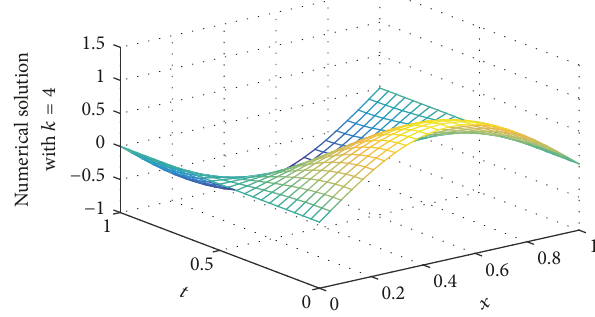
Figure 8: Numerical solution with 𝑘 = 4 .